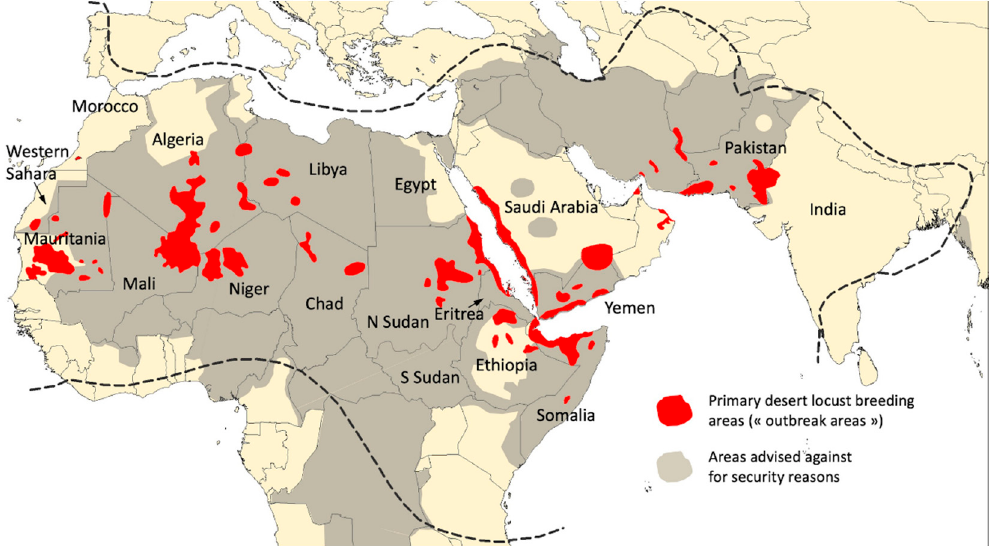
Figure 2. Proximity and overlap of major desert locust breeding areas with areas advised against and formally advised against by the French Ministry of Europe and Foreign Affairs for safety concerns [13] and other foreign ministries and departments of other “western” countries; the dotted lines indicate the limits of the desert locust invasion area [12]; 1986 through October 2020.